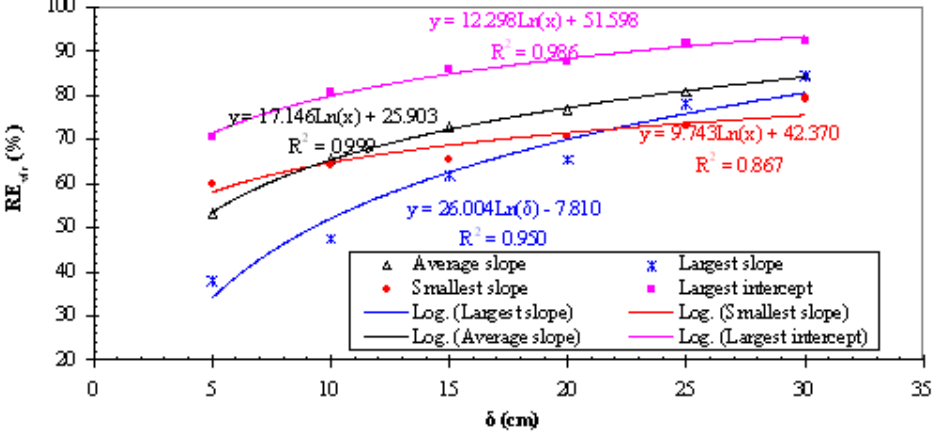
Figure 2. Measured relative vapor flow resistance (VFR) effect (RE vfr in Equation (3)) versus thickness ( δ ) of dry soil layer (DSL) at a site in the Horqin Sandy Land (after